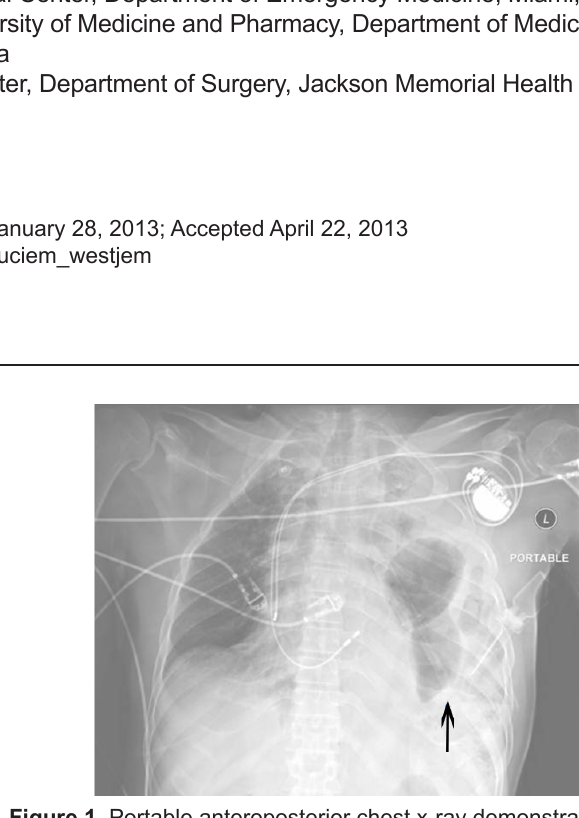
Figure 1. Portable anteroposterior chest x-ray demonstrating left rib fractures, hemothorax and left diaphragmatic rupture (arrow). Biventricular pacer is also noted.